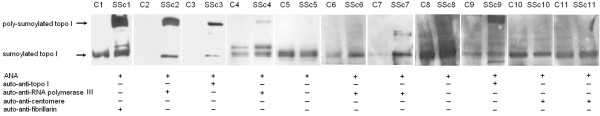
Immunoprecipitated Western blots and autoantibody profiles for 11 SSc patients. Each SSc patient (SSc1 to 11) has an age and sex matched normal control (C1 to 11) for comparison of sumoylated topo I expression with IP Western blots. Poly-sumoylated topo I appeared in SSc fibroblast strain number 1, 2, 3, 4, 7 and 9. Increased sumoylation of topo I also is observed in the case number 6 compared to its normal counterpart, but not in the case number 5, 8, 10 and 11. ANA, antinuclear antibodies.